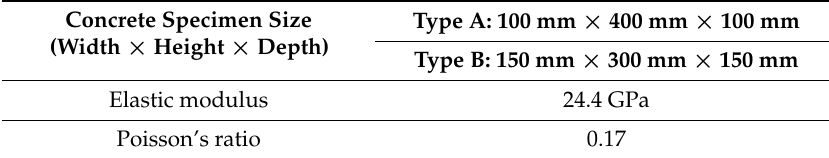
Table 1. Specimen